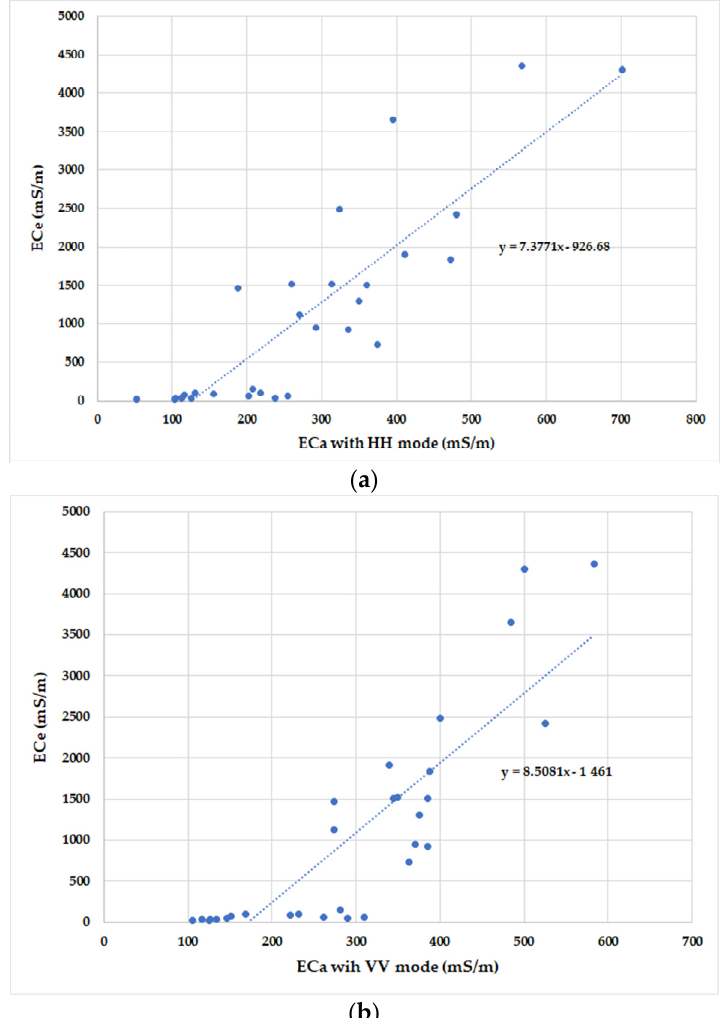
Figure 8. A scatter plot between ECa of two measuring modes: ( a ) HH and ( b ) VV and ECe for LRA. Table 6. The average ECe and ECa of two measuring modes for linear regression analysis.